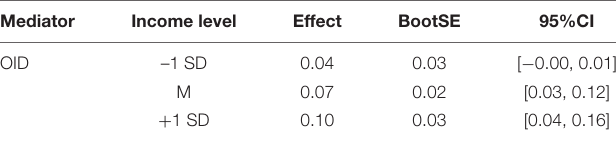
TABLE 4 | Conditional indirect effect of income level when organizational identification (OID) mediated between PsyCap and job